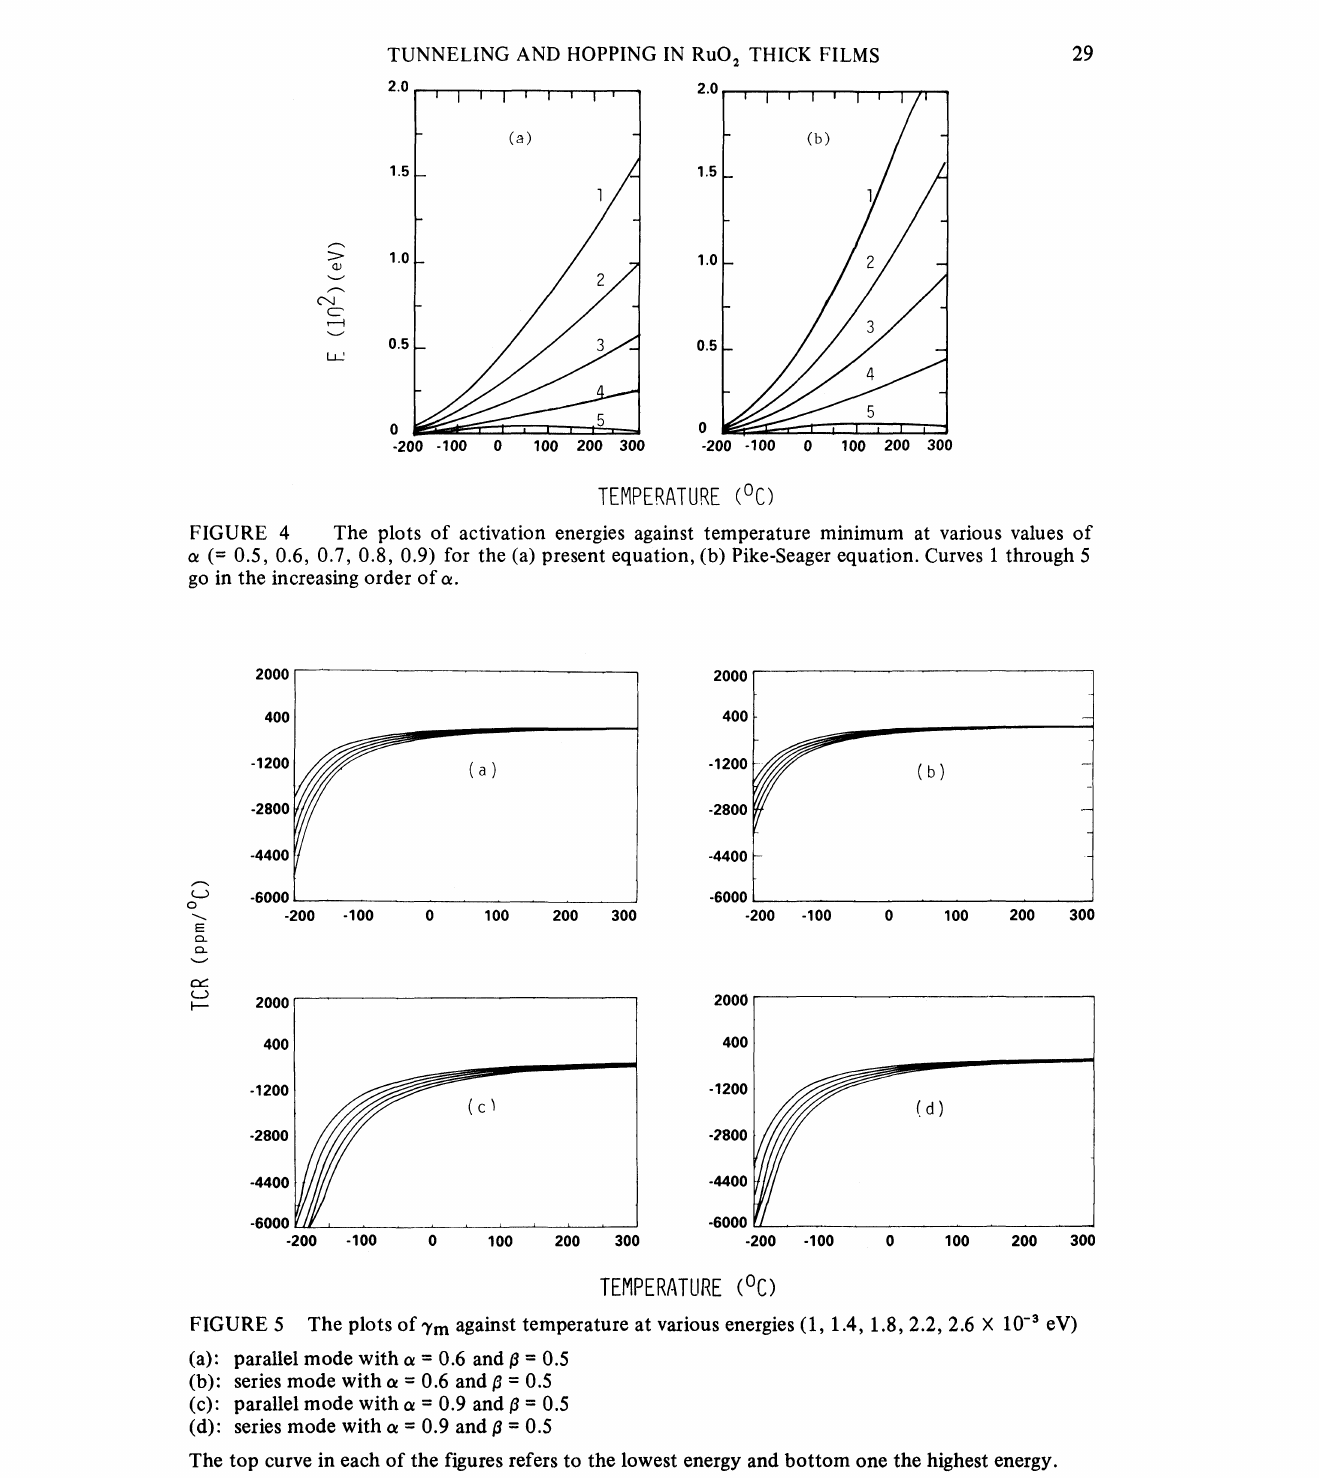
FIGURE 5 The plots of-m against temperature at various energies (1, 1.4, 1.8, 2.2, 2.6 10 -3 eV) (a): parallel mode with a 0.6 and/3 0.5 (b): series mode with a 0.6 and/3 0.5 (c): parallel mode with a 0.9 and/3 0.5 (d): series mode with a 0.9 and/3 0.5 The top curve in each of the figures refers to the lowest energy and bottom one the highest